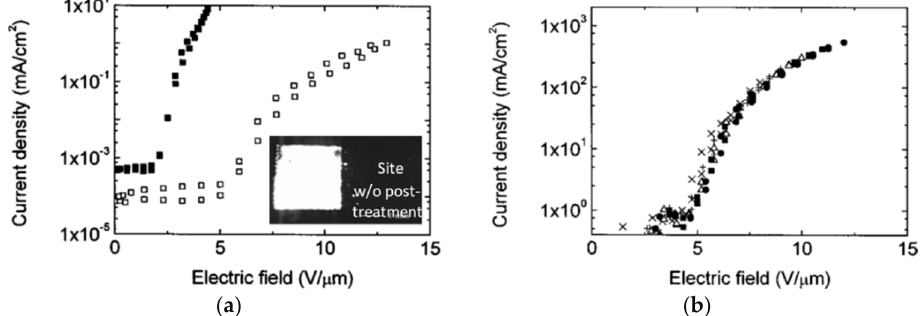
Figure 14. Emission enhancement by a postprocess treatment: the FE characteristics of a screen-printed CNT film before ( a ) and after the postprocess treatment ( b ). The inset in ( a )—the emission site density image with (left) and without (right) postprocess treatment.Figure 14a,b reprinted with permission from [133].